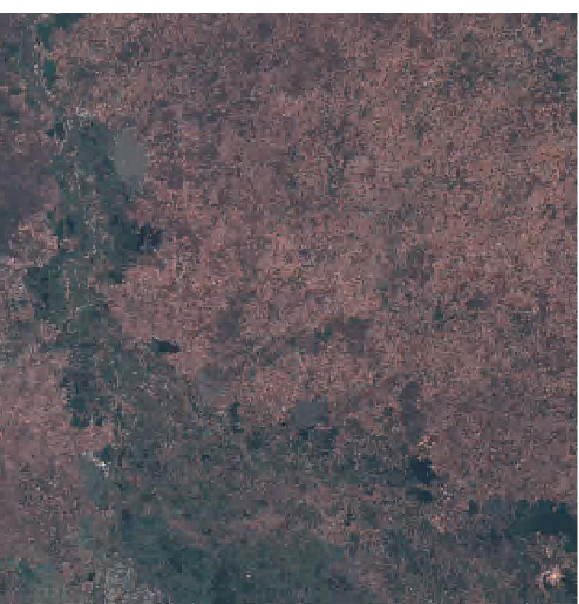
Figure 4: Non-hazy